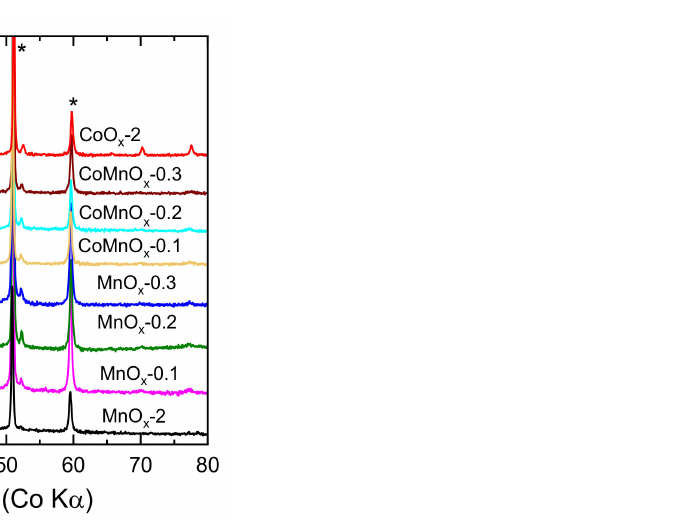
Figure 1. Powder XRD patterns of the catalysts calcined 4 h at 500 ◦ C (*—stainless steel